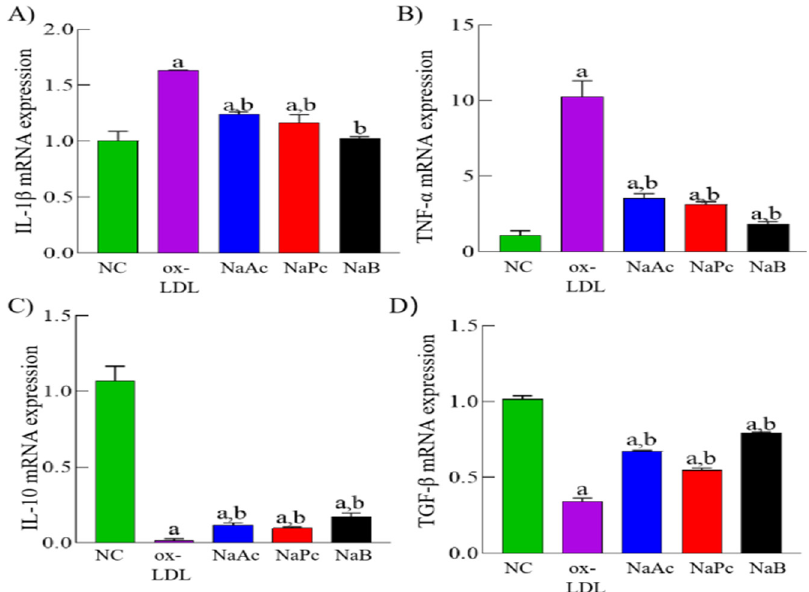
Figure 1. The pro-inflammation cytokines expressions of THP-1 cells. The THP-1 cells were pre- treated with 50 mg/L ox-LDL for 24 h and then treated with 200 µ mol/L NaAc, NaPc, and NaB for 24 h. The cytokines expressions were determined by qPCR assay. ( A ) IL-1 β . ( B ) TNF- α . ( C ) IL-10. ( D ) TGF- β . a p < 0.05 vs. NC group. b p < 0.05 vs. ox-LDL group.